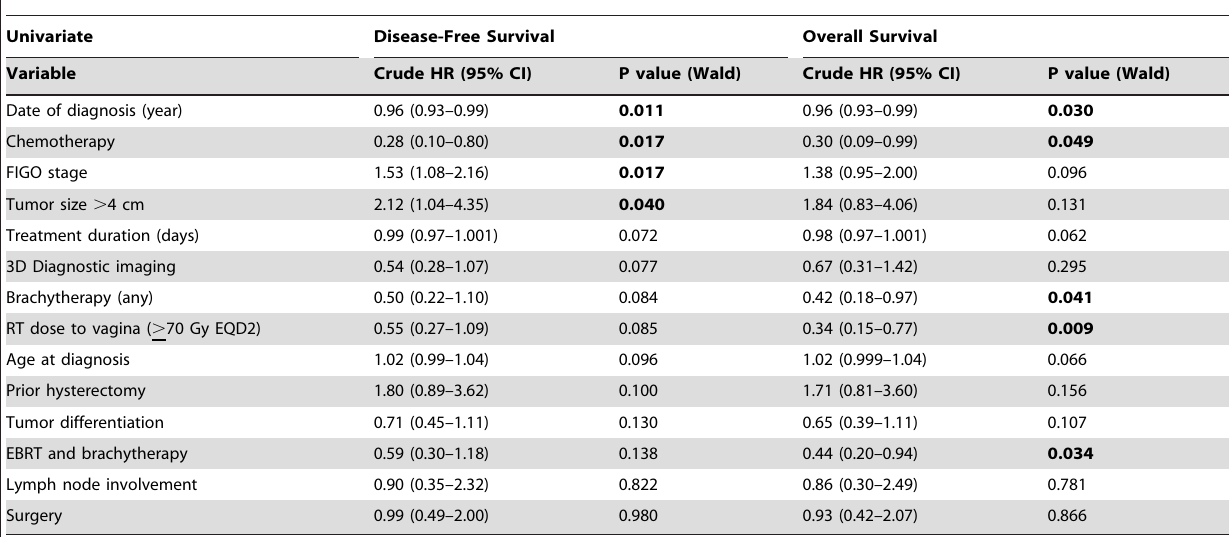
Table 3. Cox proportional hazards analyses.